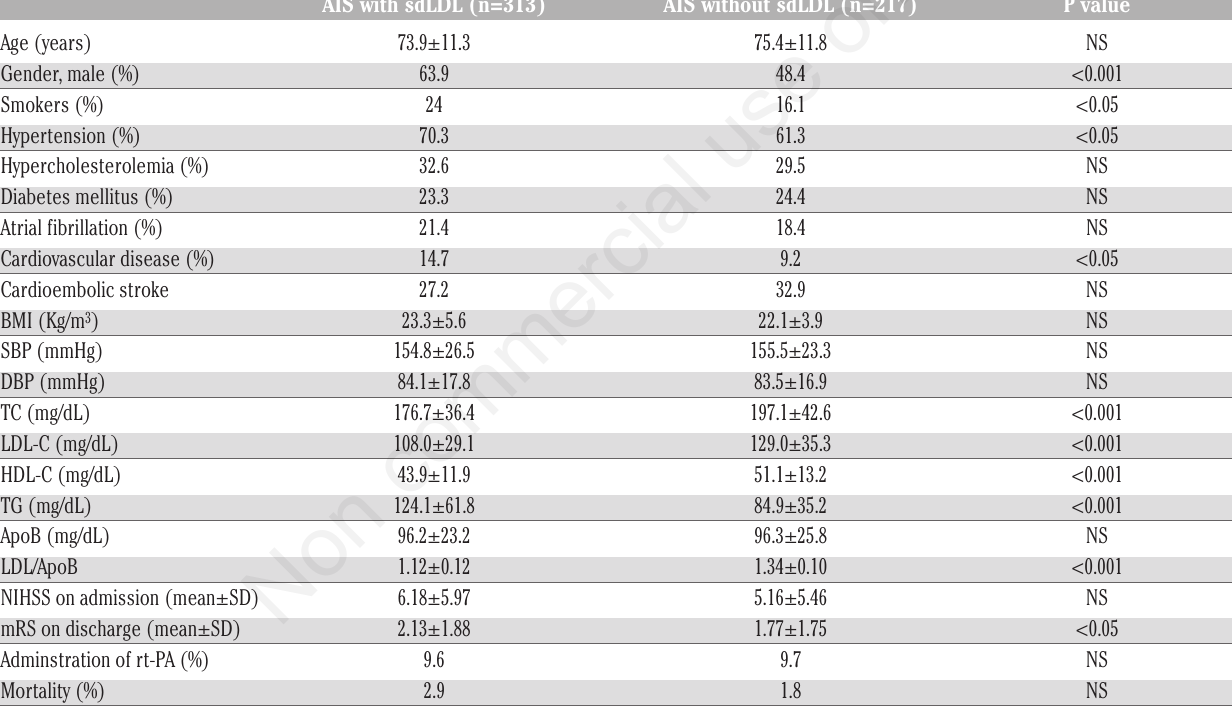
Table 2. Comparisons of acute ischemic stroke patients with or without small dense low-density lipoprotein. AIS with sdLDL (n=313)